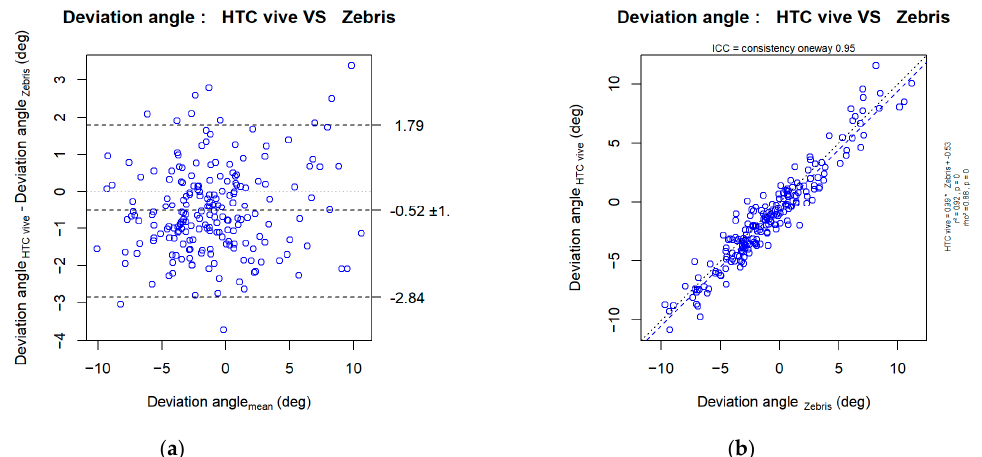
Figure 7. ( a ) Bland–Altman plot; ( b ) Regression plot (right panel) of the angle measured by the HTC Vive ® system versus the Zebris motion capture system considered as the gold standard. The angles of deviation obtained with the HTC Vive ® and Zebris are highly correlated, but a slight underestimation was made with the HTC Vive ®